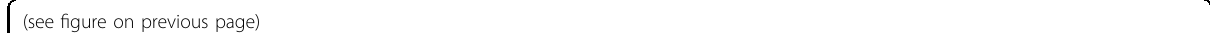
Fig. 3 In vivo combined chemotherapy – birinapant treatments reduces xenograft growth rate and overcomes carboplatin antagonism. A Dose and administration schedule for carboplatin, paclitaxel, and birinapant. Mice were inoculated with human ovarian cell lines Ovcar8 with Caspase 8 control (WT) or knockdown (KD). When subcutaneous tumors reached 100 – 200 mm 3 or at 15 – 20 days for post intraperitoneal inoculations, mice were randomized into groups of 5. Aqueous solutions of birinapant (Tetralogic, in citrate buffer), carboplatin (Teva), and paclitaxel (Teva) were administered intraperitoneally in 500 µl volumes once weekly × 3 weeks or thrice weekly × 3 weeks at the indicated doses. For simultaneous treatments, drug combinations were administered at the same time (CP, CPB), while for sequential treatments, drugs were administered simultaneously on days 1, 3 and 5 (CP-P-P; CP-PB-PB) at doses indicated in the chart. Subcutaneous tumors were measured twice a week as described for 50 – 60 days or when tumors reached humane endpoints, and IP tumors were assessed after 70 – 80 days or when health assessments indicated that a humane endpoint had been reached. B Subcutaneous tumor volume increases during and following chemotherapy/birinapant combination treatments of Ovcar8 xenografts expressing wild-type Caspase 8. Points are average of 5 mice; weekly treatments are indicated by black arrows. C Subcutaneous tumor volume increases during and following chemotherapy/birinapant combination treatments of Ovcar8 xenografts expressing low Caspase 8. Points are average of 5 mice; weekly treatments are indicated by black arrows. Single asterisk (*) represents p < 0.05, based on t test, and shown as percentage of change from vehicle-treated mice. D – G Overall survival of mice bearing intraperitoneal tumors expressing control (Caspase 8 WT) or low Caspase 8 (Caspase 8 KD), treated with simultaneous ( D , E ) or sequential ( F , G ) chemotherapy/birinapant administration as described in A . p Values represent two-tail, log-rank comparisons between the indicated survival curves.